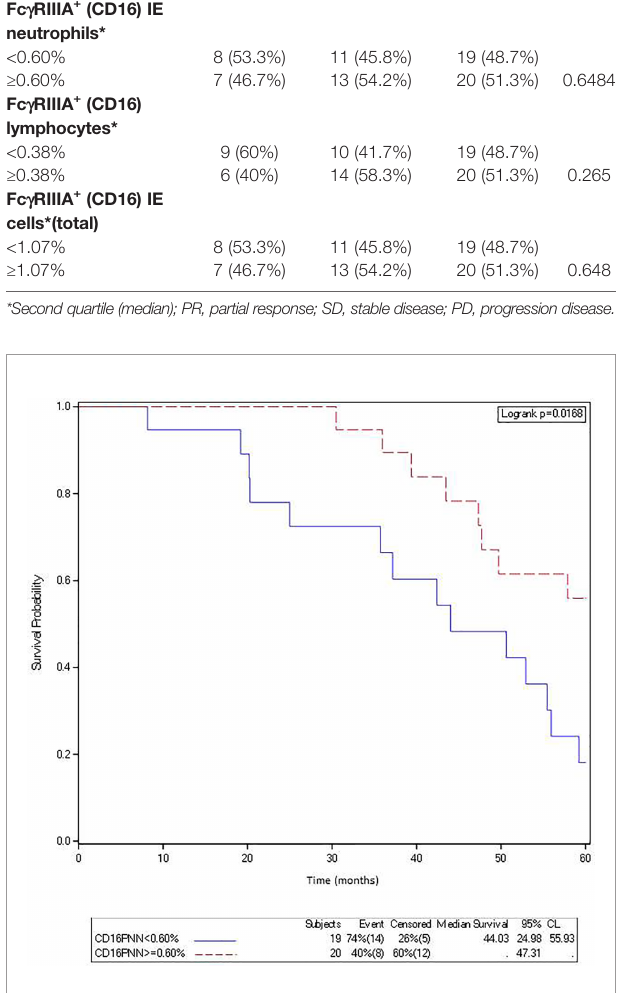
FIGURE 3 | The density of Fc g RIIIA + (CD16) intraepithelial TAN in metastasis is associated with a better overall survival in mCRC patients treated with cetuximab. Kaplan-Meier curves depict overall survival of patients with a mCRC featuring a low (solid curve) or a high (broken curve) density of Fc g RIIIA + (CD16) intraepithelial TAN (second